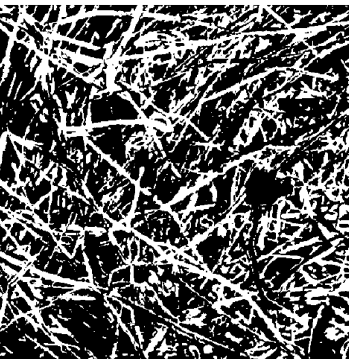
Figure 9. Image after binarization.